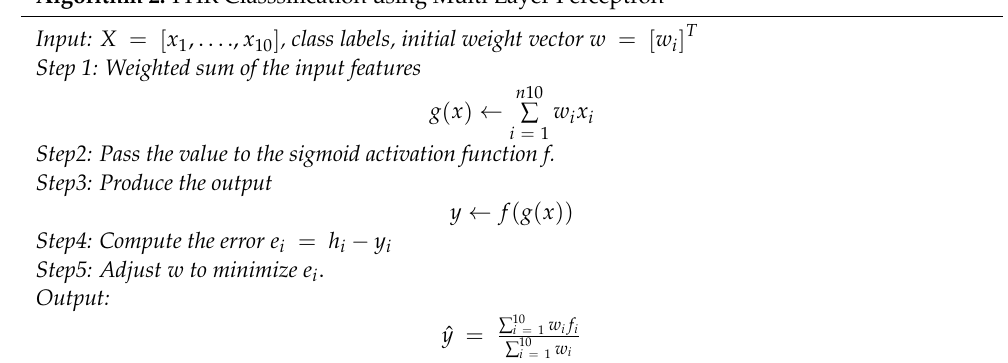
Algorithm 2: FHR Classsification using Multi Layer